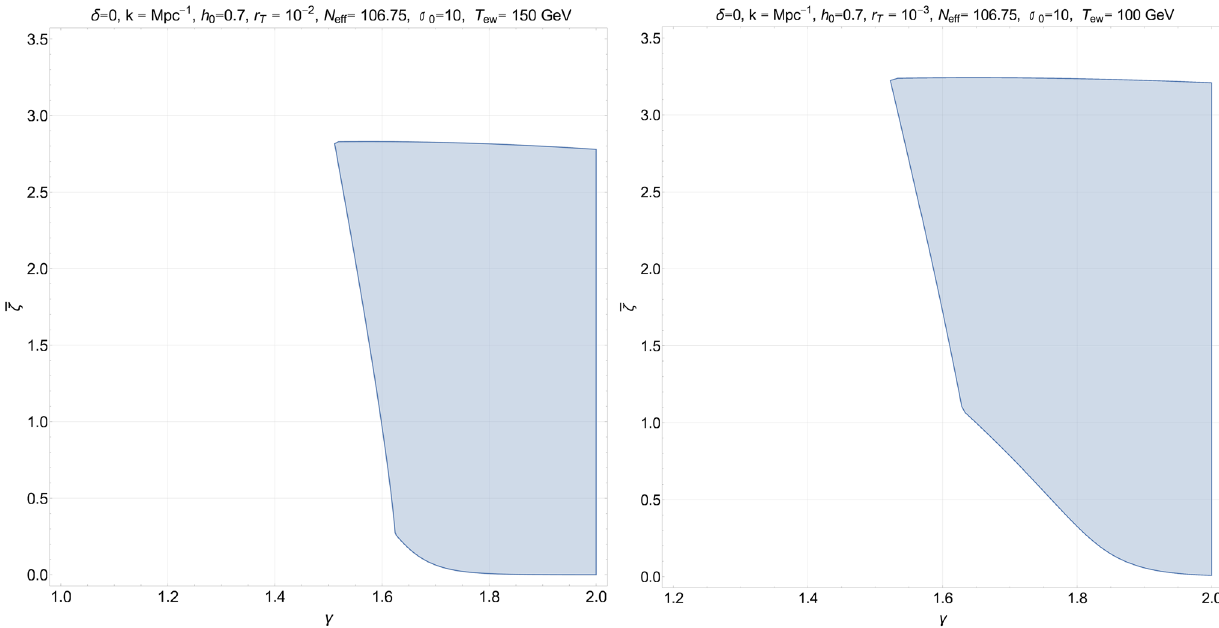
Fig. 8 The shaded area illustrates the region of the parameter space where the baryogenesis and the magnetogenesis constraints are simultaneously